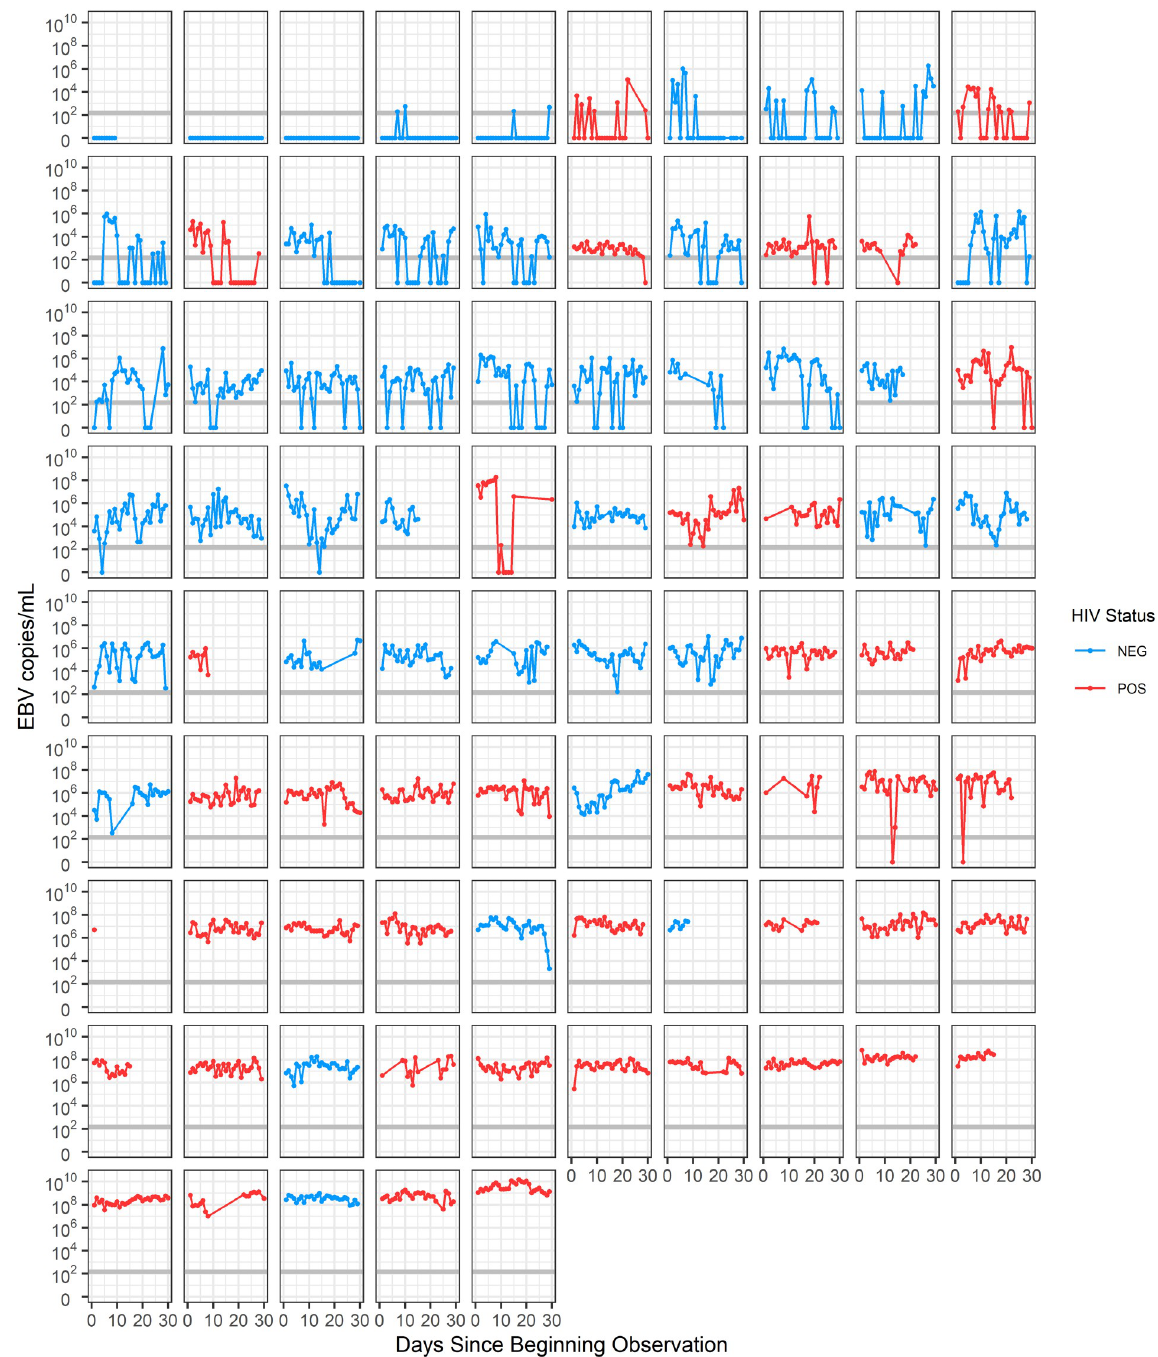
Fig 1. Viral shedding patterns of study participants. Viral loads in the saliva of study participants were measured daily via qPCR for a median of 29 days. Swabs up to 30 days post initiating observation are shown. Each plot represents the shedding pattern of a separate participant. Patients are arranged according to their median viral load. The grey horizontal line represents the threshold of EBV detection (150 EBV copies/ ml).